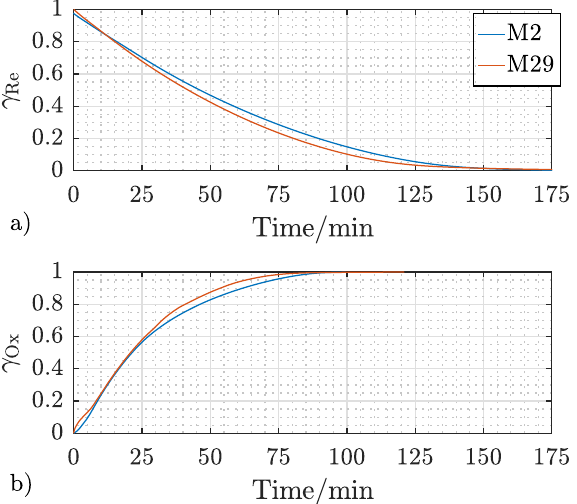
Figure 9. Reaction behavior of S1 after two (M2) and 29 (M29) redox cycles at a reactant flow rate of 250mL/min, reaction temperature of 700°C, and the gas concentration ro 3 (cf. Table 2) for reduction ( a ) and oxidation ( b